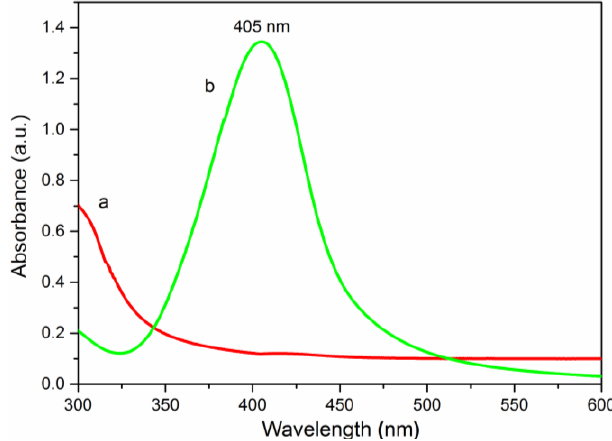
Figure 7. Ultraviolet-visible (UV-Vis) spectra of ( a ) QCMC and ( b ) QCMC-Ag.